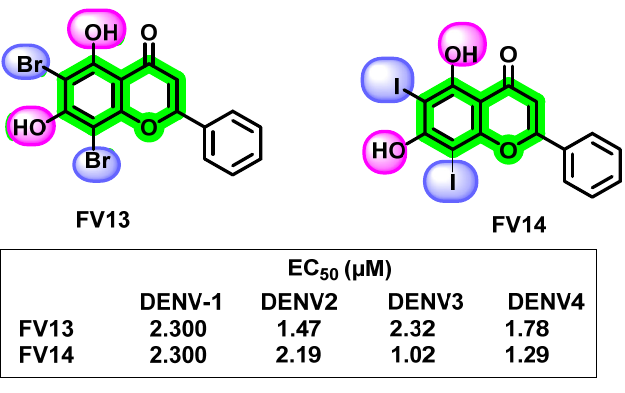
Figure 20. Structure and EC 50 values of halogenated chrysins on four serotypes of DENV.